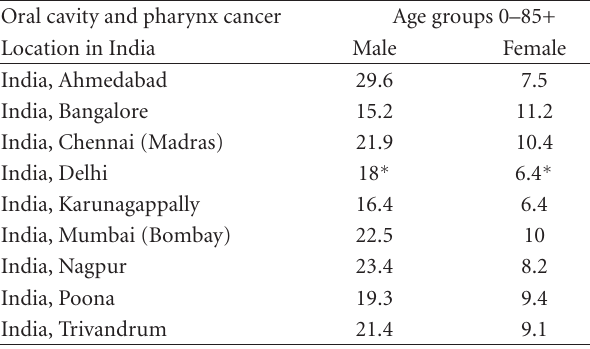
Figure 7: Crude incidence projections for lip/oral cavity cancer (2008 to 2030). Data extracted from Globocan, 2008 data. Pop- ulation forecasts were extracted from the United Nations, World Population prospects, the 2008 revision . Numbers are computed using age-specific rates and corresponding populations for 10 age-